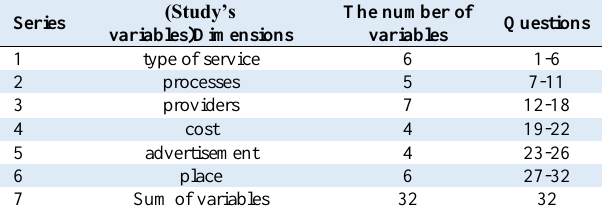
Table 1. Study’s dimensions and scales in the distributed questionnaire (Study’s variables)Dimensions